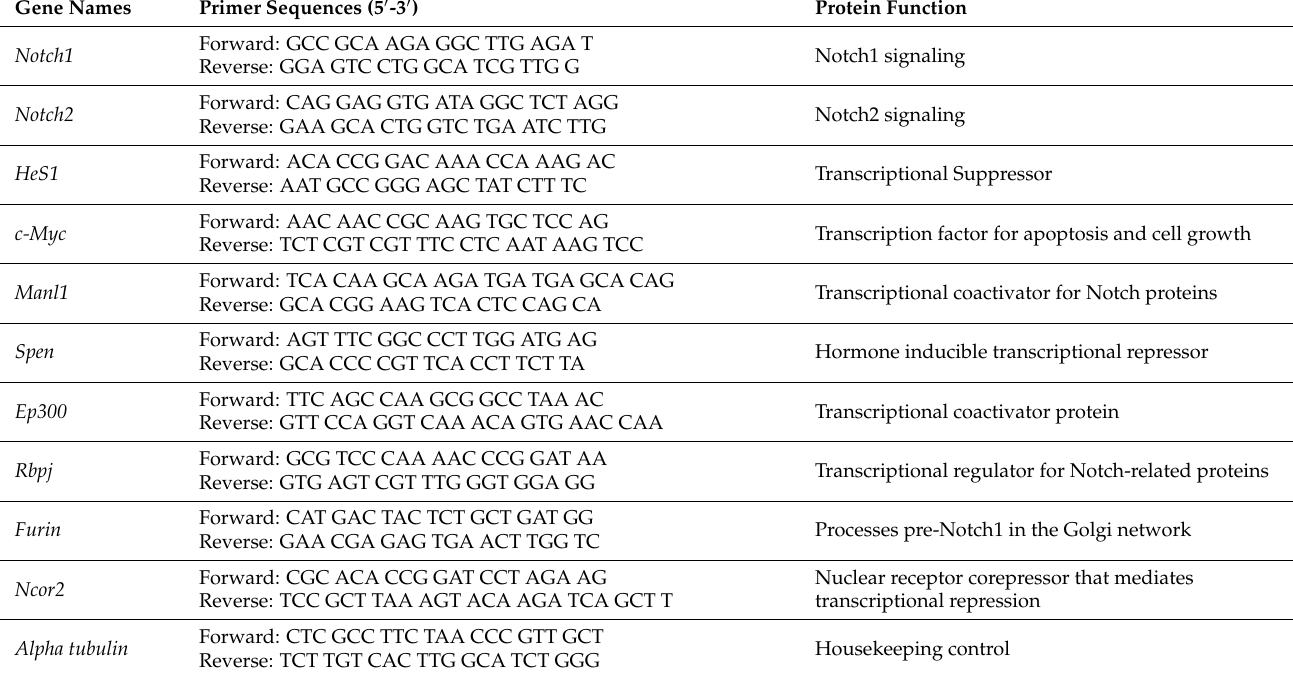
Table 1. Primers for